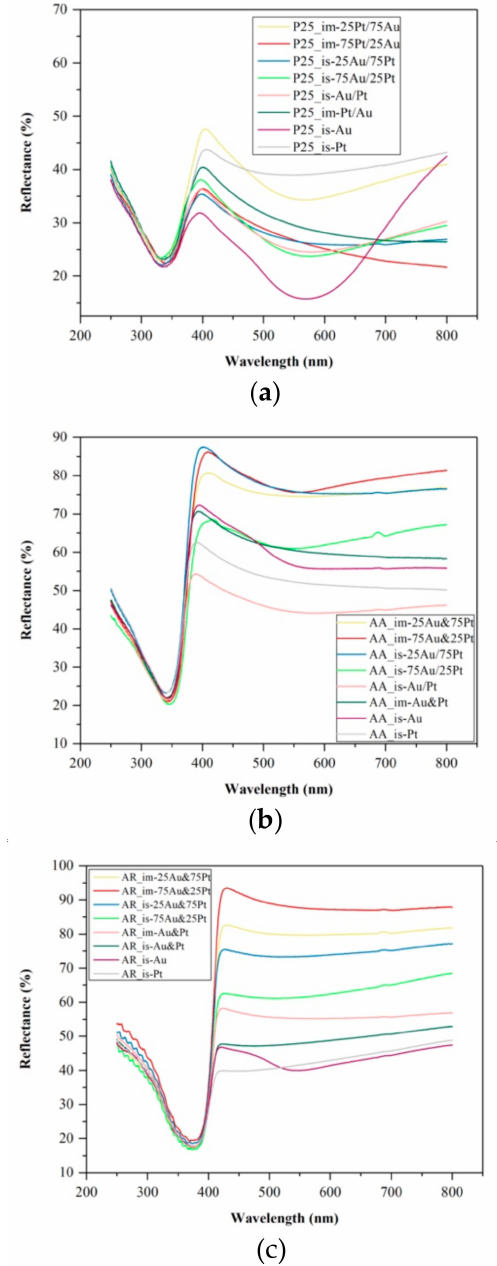
Figure 6. Diffuse reflectance spectroscopy (DRS) spectra of the ( a ) P25-based, ( b ) AA-based and ( c ) tAR-based